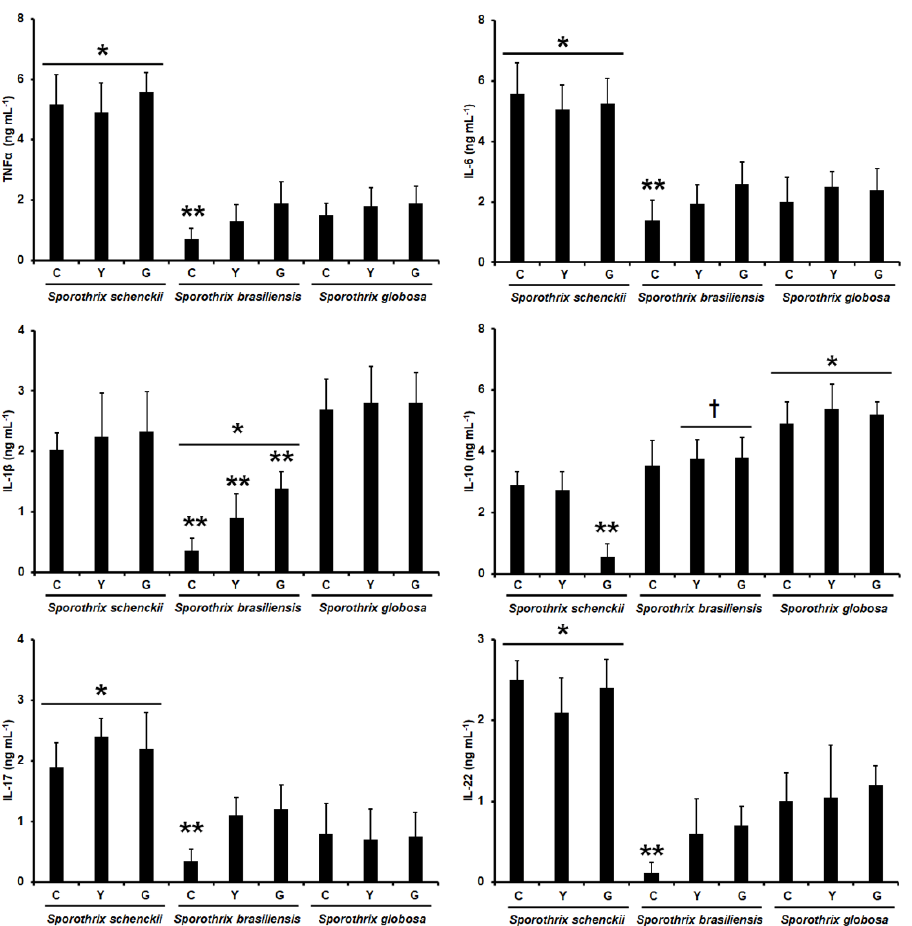
Figure 2. Cytokine production by human peripheral blood mononuclear cells stimulated with Sporothrix schenckii , Sporothrix brasiliensis, or Sporothrix globosa . For tumor necrosis factor-alpha (TNF α ), interleukin 1 β (IL-1 β ), interleukin 6 (IL-6), and interleukin 10 (IL-10), human peripheral blood mononuclear cells were co-incubated for 24 h with live conidia, yeast-like cells, or germlings from the fungal species under study. Alternatively, for interleukin 17 (IL-17) and interleukin 22 (IL-22) stimulation, the human cells were co-incubated with the UV-inactivated fungal cells. In all cases, the interactions were centrifuged, supernatants collected, and cytokines quantified by ELISA. C—conidia; Y—yeast-like cells; G—germlings. Results are the median ± standard deviation from data generated with samples from eight donors, analyzed in duplicate. * p < 0.05 when compared with the cytokine level stimulated by other Sporothrix species; ** p < 0.05 when compared with the cytokine levels stimulated by the other morphologies of the same species; † p < 0.05 when compared with the cytokine levels stimulated with S. schenckii